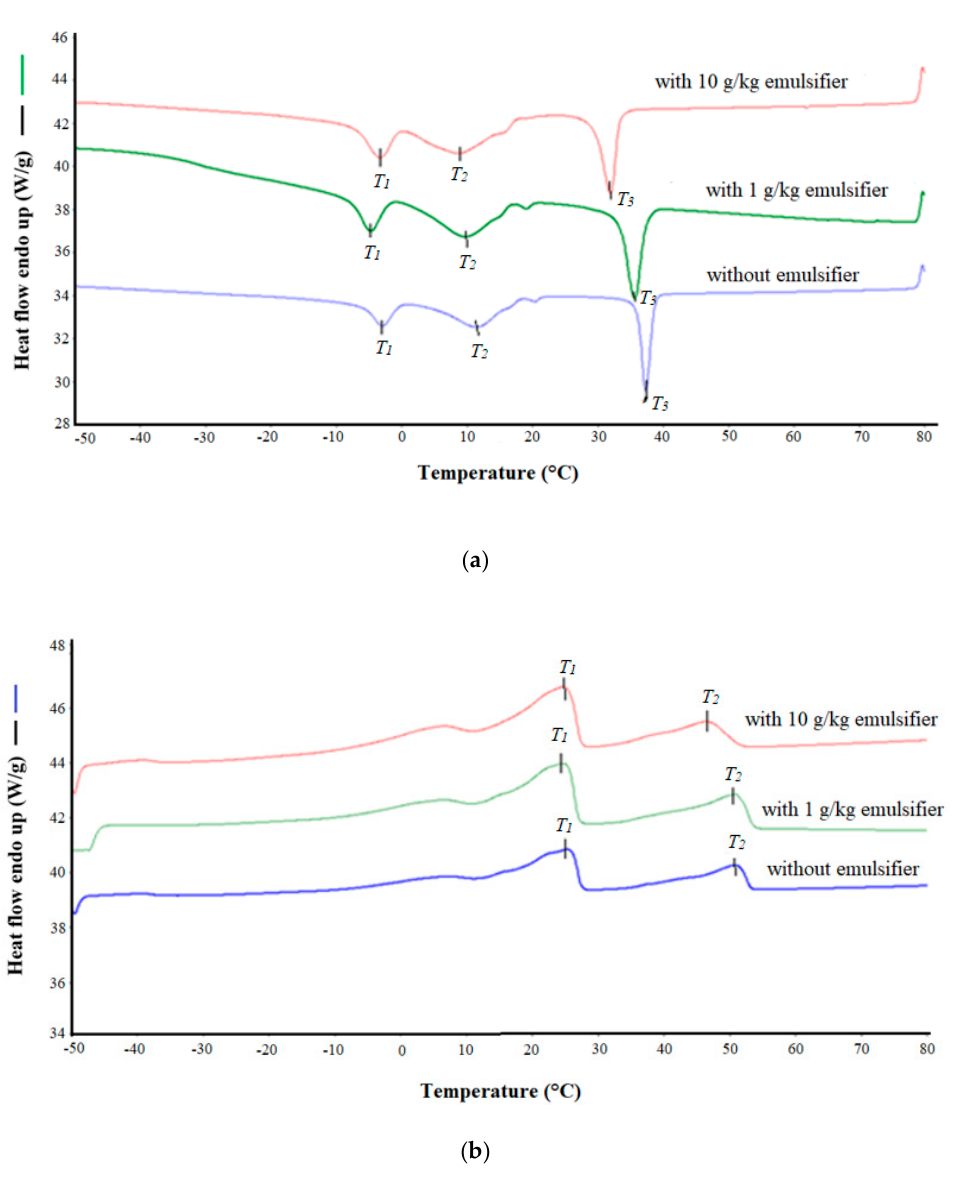
Figure 2. Changes in the dynamic ( a ) crystallization and ( b ) melting properties of palm olein-based diacylglycerol (POL-DAG) oil with and without emulsifier. Table 1. Dynamic crystallization and melting parameters of palm olein-based diacylglycerol (POL-DAG) oil with and without emulsifier (scanned at 5 °C min − 1 ).